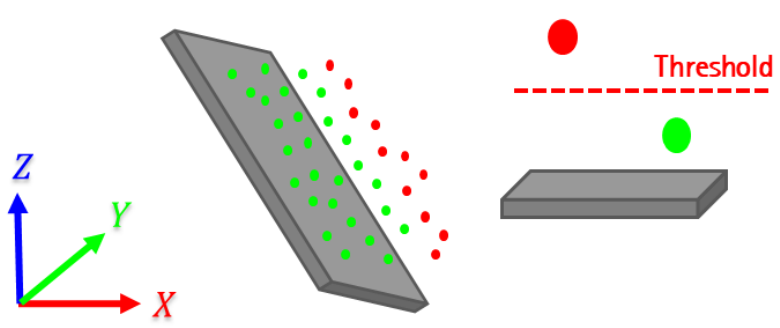
Figure 2. Scheme of the assigned scanned data to the building facades.